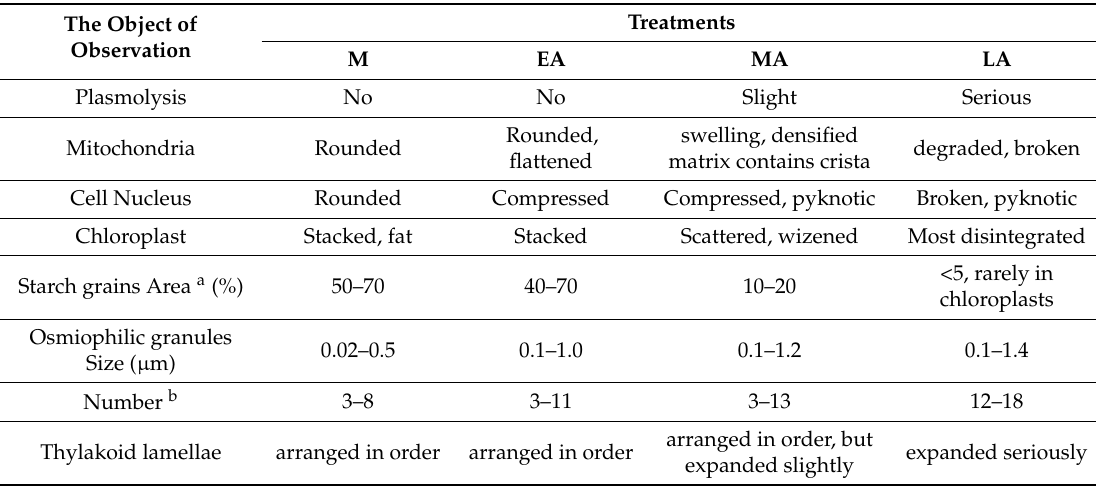
Table 1. Ultrastructural changes in mesophyll cells during the process of premature senescence.